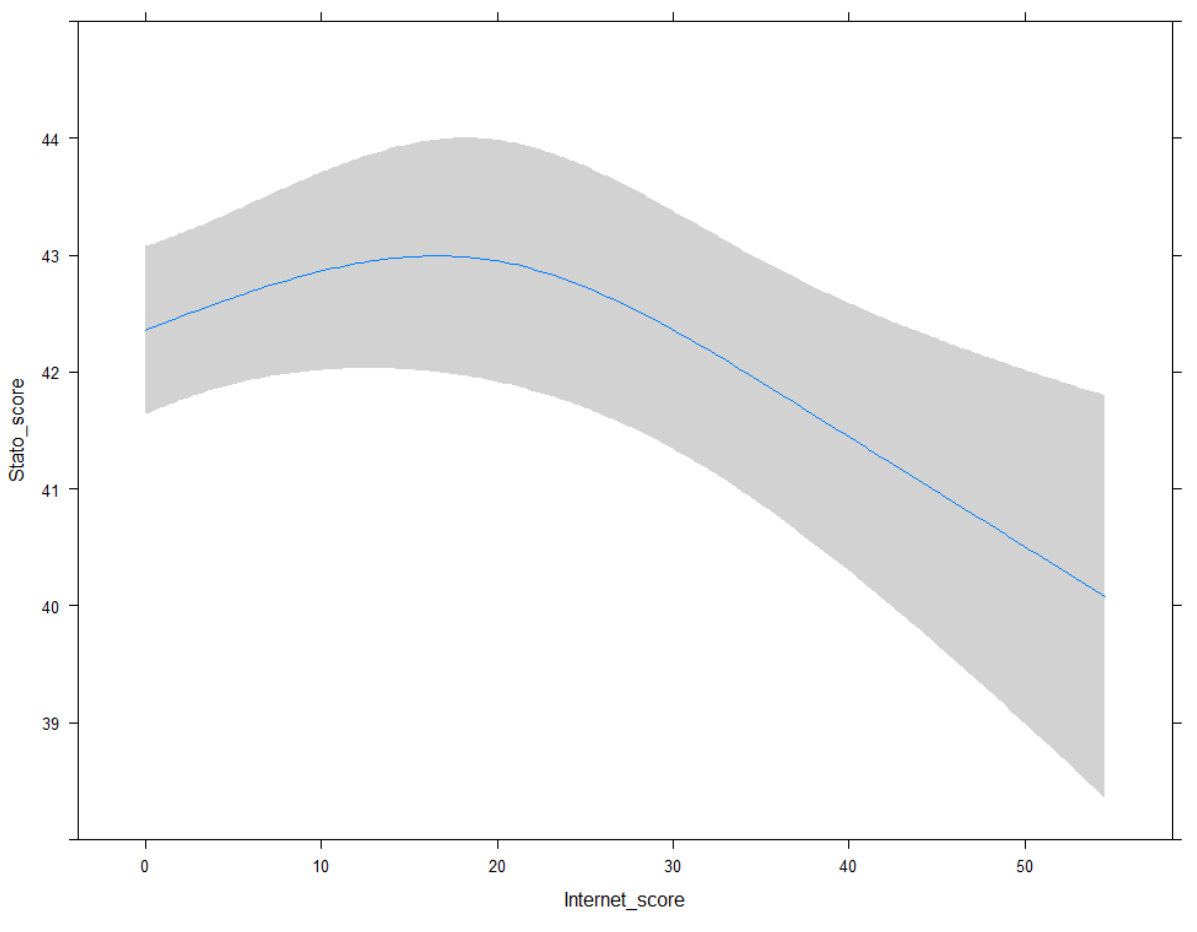
Figure 3. Association of UIH-VAS and STAI-State score. Non linearity ( P =.007) estimated via restricted cubic splines and adjusted for EQ5D-VAS, age, critical events, and drug consumption. UIH: Use of Internet Health-information Questionnaire; VAS: visual analog scale; STAI: State-Trait Anxiety Inventory; EQ5D: EuroQOL 5 dimensions